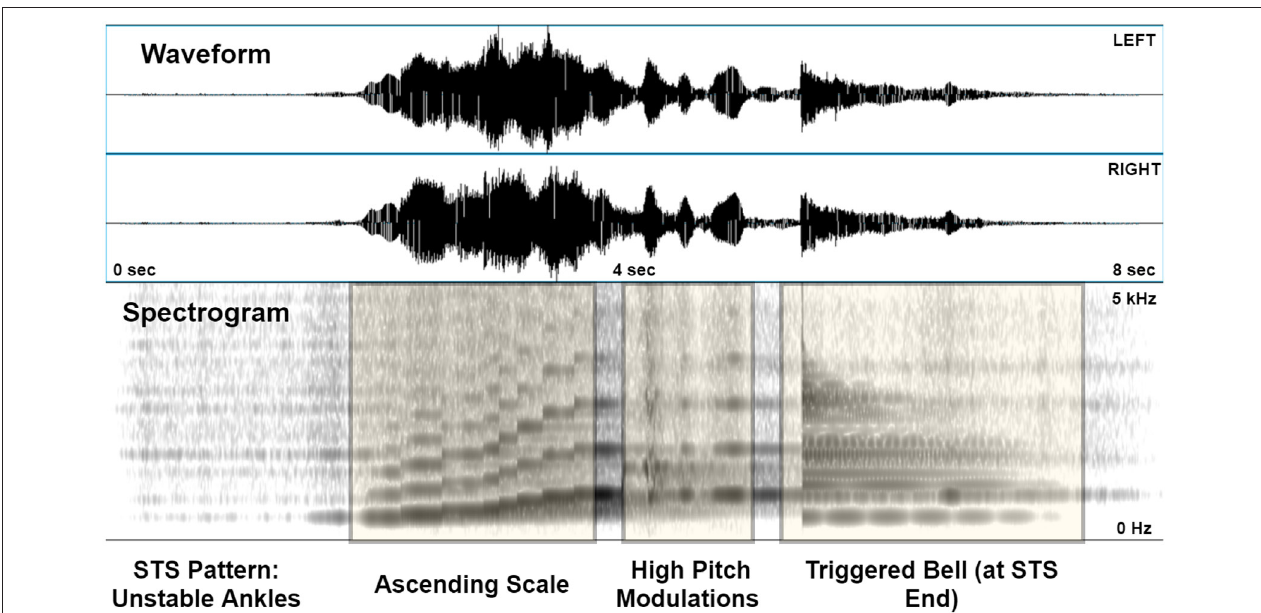
FIGURE 2 | A sonified version of the “Unstable Ankles” pattern, shown as a stereo (2-channel) waveform and spectrogram (0–5 kHz, linear scaling) generated in PRAAT. The latter depicts the ascending scale, high pitch modulations post-rise, and the triggered bell on coming to rest after